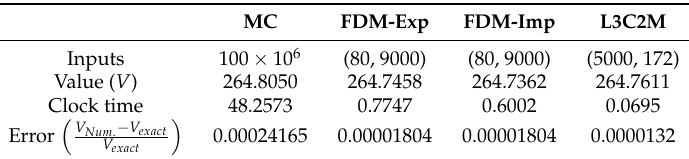
Table 3. Comparison of the numerical